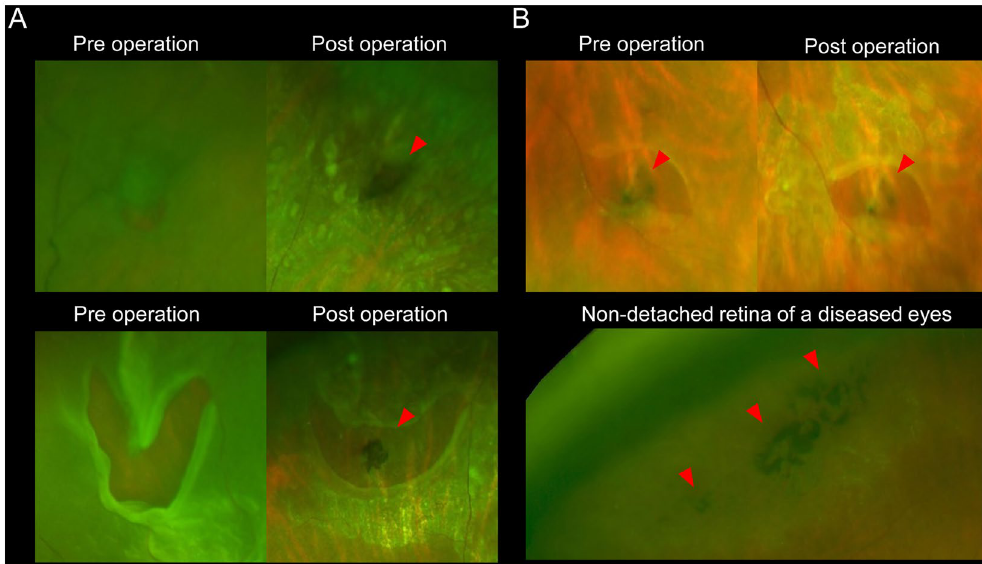
Figure 2. Pigmentary lesion (PL) of eyes with rhegmatogenous retinal detachment (RRD) examined by pre- and postoperative ultra-wide field (UWF) scanning light ophthalmoscopy (SLO). ( A ) Pigmentary lesion (PL) without lattice degeneration (LD) in representative two RRD-eyes. The preoperative UWF-SLO images do not clearly show the PL. However, the postoperative UWF-SLO images show the PL in and behind the retinal tears, at the retinal pigment epithelial level. In the eyes, the retinal tears do not accompany the LD lesion. ( B ) PL without LD in other RRD-eyes. The pre- and postoperative SLO images show the PL. Red arrowheads indicate PL.